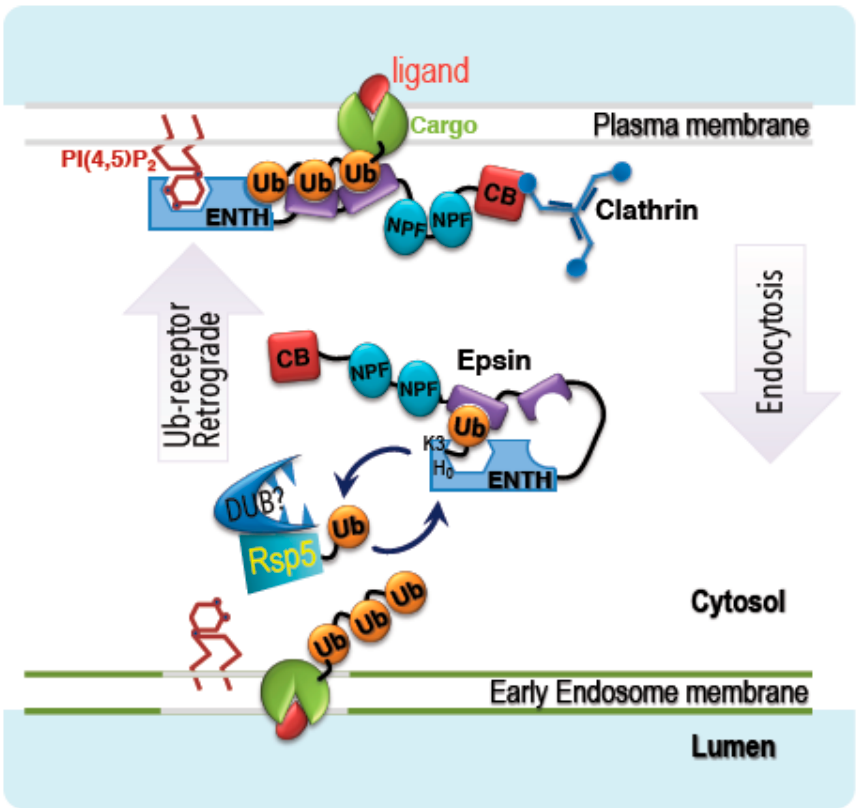
Figure 6. A model for the function of Ent1 ubiquitylation to initiate a retrograde process. Ent1 binds to the plasma membrane via the interaction of the ENTH domain with PIP 2 . The three UBDs of Ent1 bind to ubiquitylated cargo, and the clathrin binding box (CB) recruits clathrin proteins to promote endocytosis. For simplicity, other endocytic components (such as Eps15 that binds NPF modules) are not shown. Ent1 ubiquitylation takes place on early endosomes, probably by Rsp5, a process that dissociates Ent1 from the membrane. An uncharacterized deubiquitylase (DUB) that probably forms